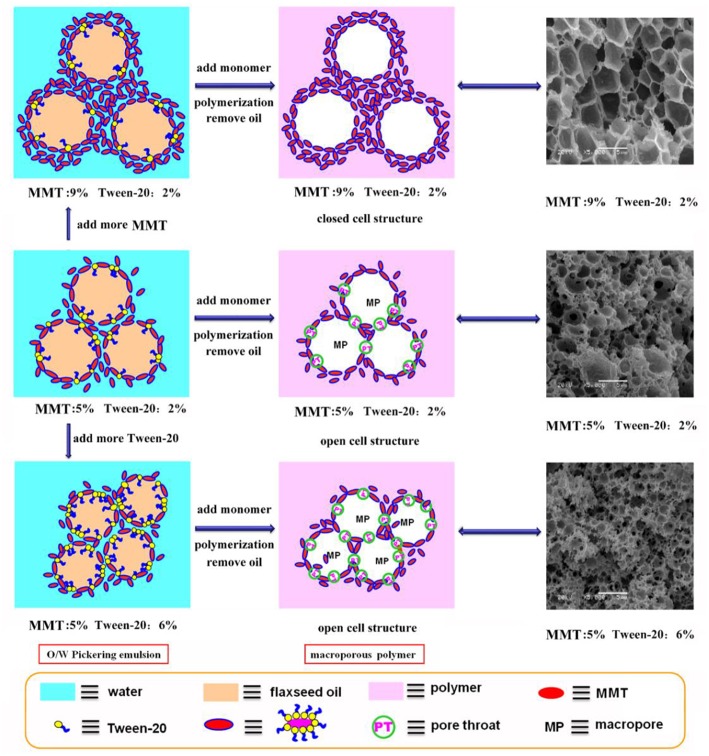
Mechanism for the formation of CMC-g-PAM/MMT with closed-cell structure or open-cell structure by adding the MMT and T-20.